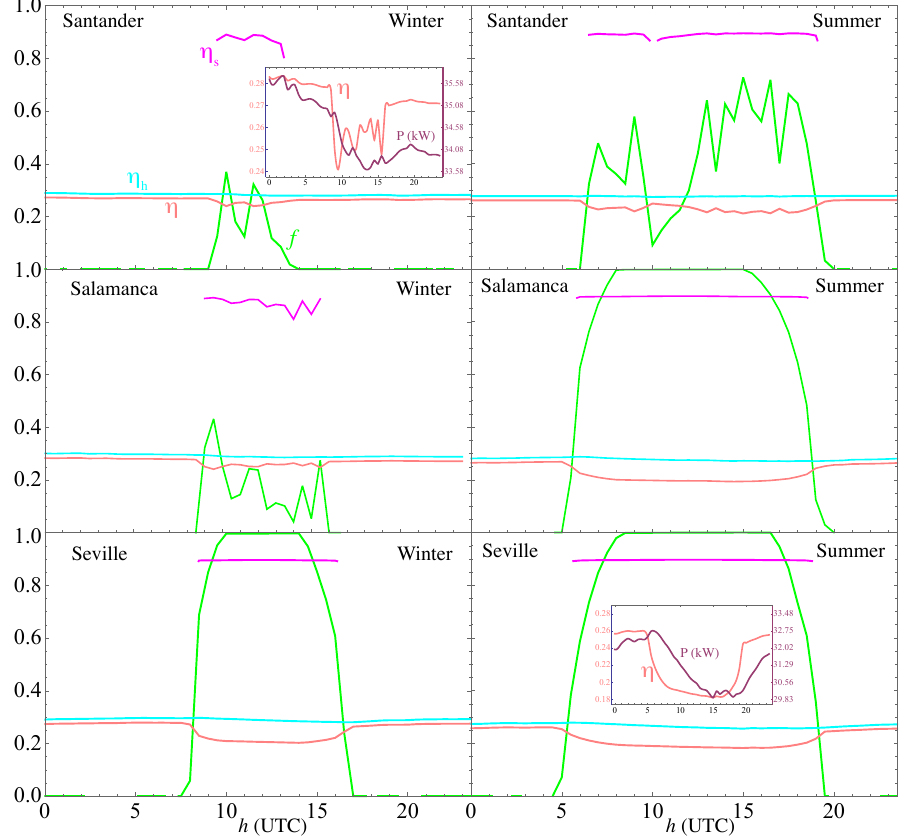
Figure 5. Overall efficiency, η , subsystems efficiency ( η s , solar, and η h , heat engine), and solar share ( f ) for the locations analyzed during particular days of winter (13 December 2017) and summer (13 June 2018). The insets show examples of the hourly evolution of overall efficiency, η , and power output, P